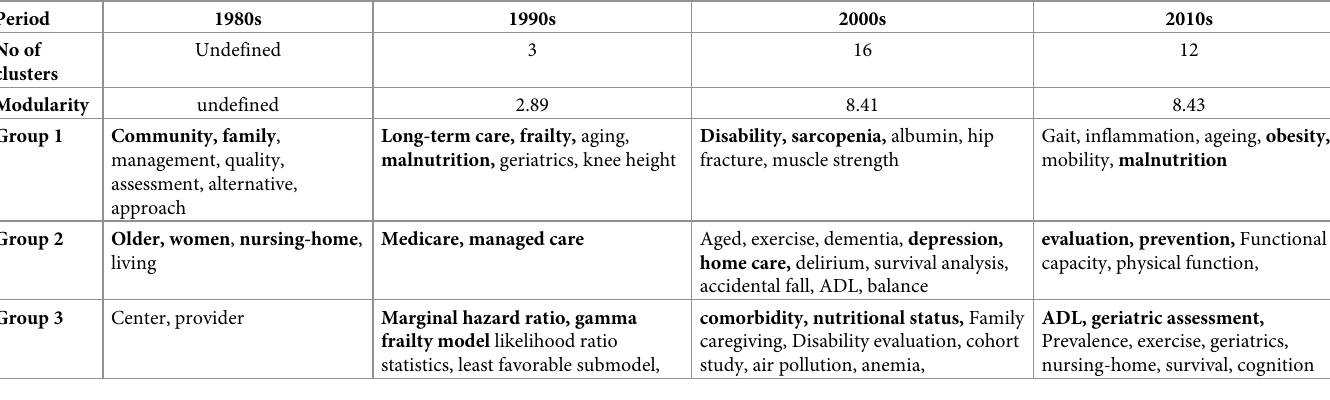
Table 2. Sub-topic groups of frailty research by cluster